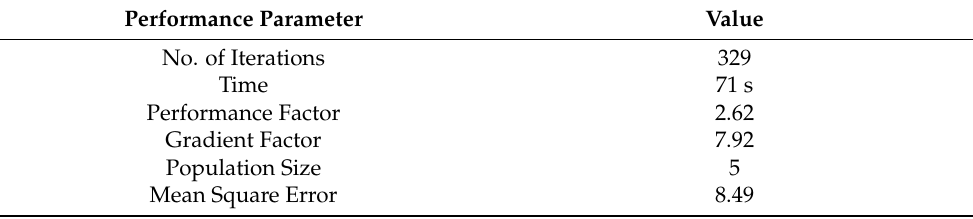
Table 3. Values of various